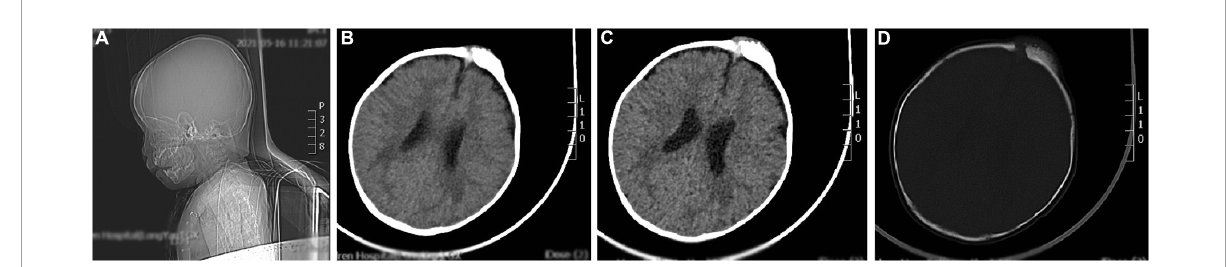
FIGURE1 A representative image of the head CT scan shows the irregular bone structure with mixed density mass on the left side of the cranial plate in the median frontal area, slightly reduced density in the bilateral parietal lobes, widening of the ventricles and extracerebral space, and thickening of the septal sinus mucosa. (A) Sagittal view shows a mass in the frontal area. (B,C) Soft tissue window at the central level of the lateral ventricle show a high-density mass in the left frontal region. (D) Bone window at the central level of the lateral ventricle: the bony structure of the left cranial plate in the middle frontal region is irregular, and there is a mixed density mass shadow.